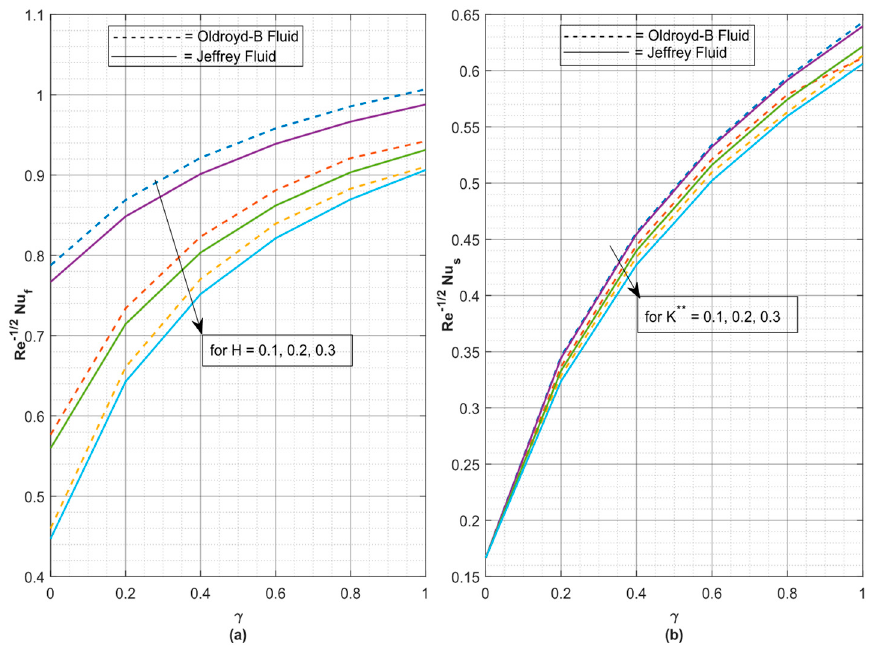
Figure 7. ( a ) Plot for fluid phase Nusselt number, and ( b ) plot for solid phase Nusselt number.